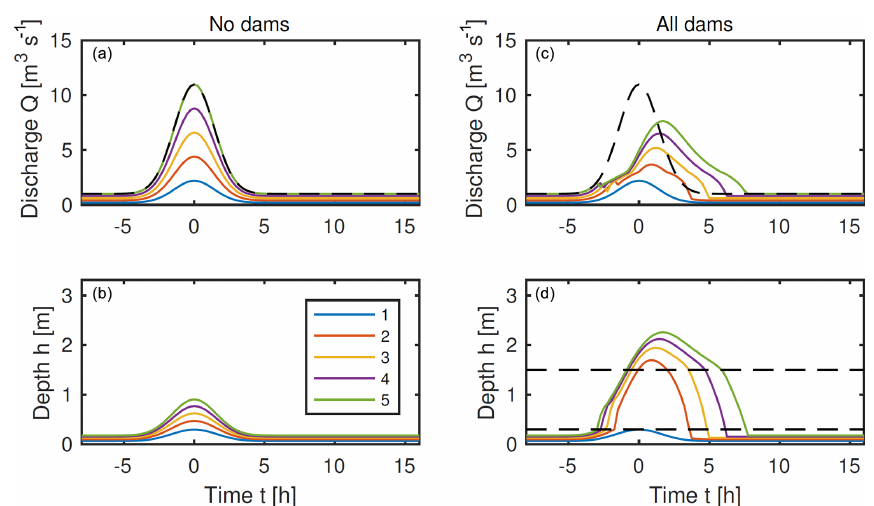
Figure 5. Solutions for a one-dimensional five-node network as in Fig. 2b, forced by uniform inflow to each node q(t) = q 0 + q max exp ( − t 2 /σ 2 ), with q 0 = 0 . 2m 3 s − 1 , q max = 2m 3 s − 1 and σ = 2h. Parameter values are as given in Sect. 2.3, together with λ = 50, b = 0 . 3m and H = 1 . 5m. Panels (a, b) show the response with no dams, when the peak discharge is almost identical to the peak cumulative inflow, shown by the dashed line in the upper panels. Panels (c, d) show the response if a dam is included on each of the five reaches. The dashed lines in (d) show the heights of the bottom and top of the dams.